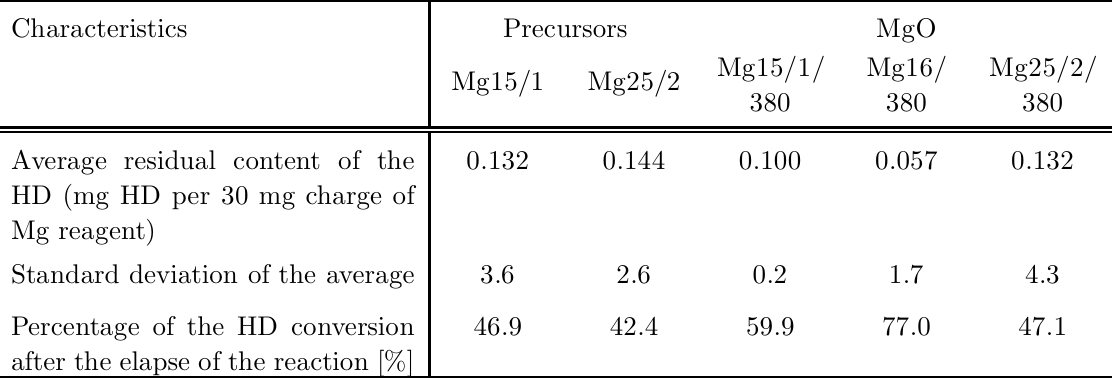
Table 5 The residual content of HD after its reaction on the magnesium samples (reaction time 1 hour, temperature 25 ¯ C, charge of the respective samples in the reaction 30 mg, 0,25mg HD dissolved in 0.1 ml